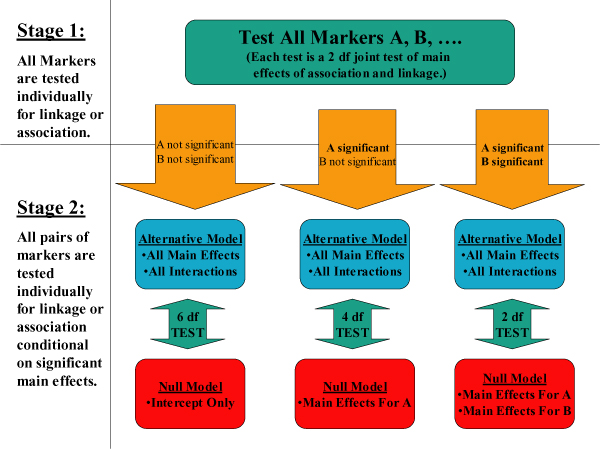
Interaction testing framework flowchart for two stages. The flow chart exhibits the first two stages of the testing framework. If tests of individual markers achieve statistical significance in the first stage, then the main effect terms for these markers are included in unsaturated (null) models in second stage likelihood ratio tests.